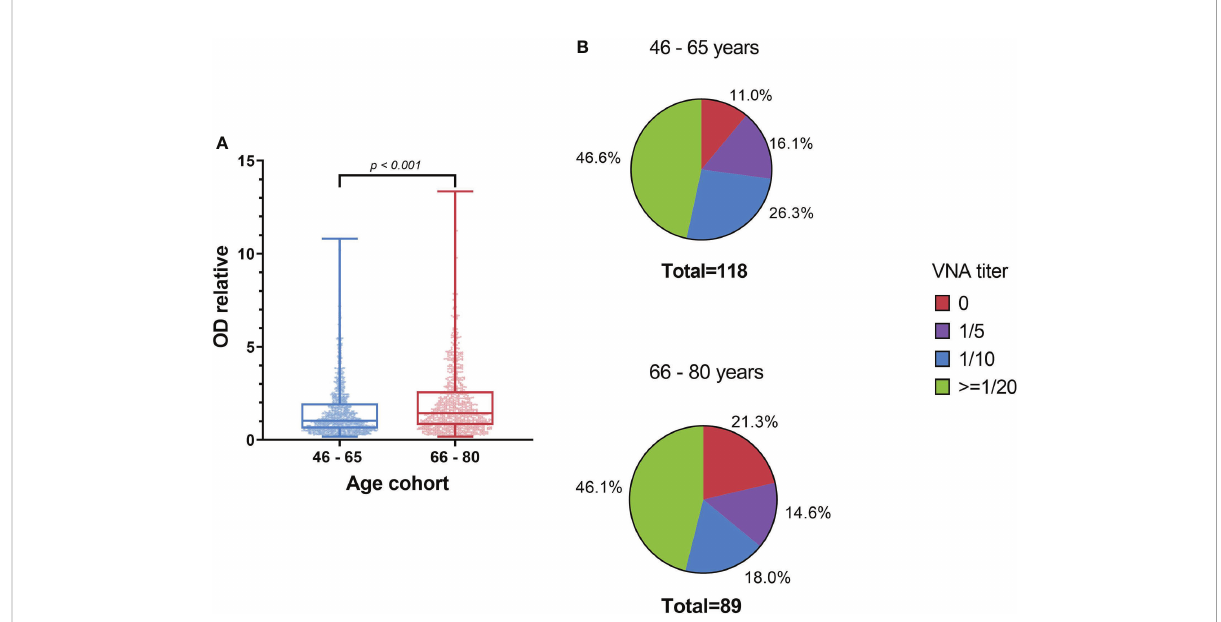
FIGURE 5 The level of antibodies to smallpox vaccine depending on the age cohort (A) and the titer of the VNA (B) . (A) shows signi fi cant differences in IgGs level between samples from 46-65 years old people and 66-80 years old people (Mann Whitney criterion). Whiskers shows maximum and minimum. (B) shows VNA titer ratio in 46-65 and 66-80 years old. p =0.333 (exact Fisher ’ s